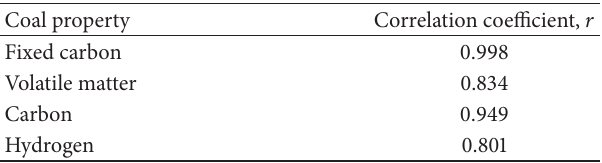
Table 7: Correlation between some coal properties and calorific